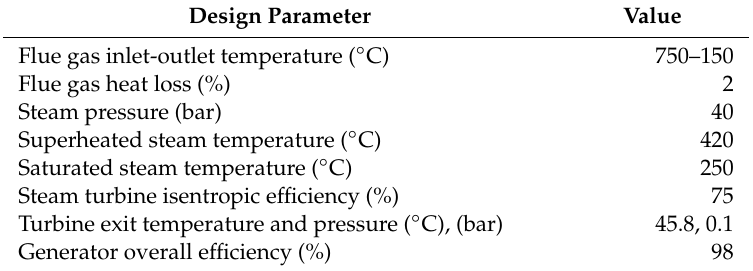
Table 3. Design parameters for waste heat recovery unit with steam turbine for electricity